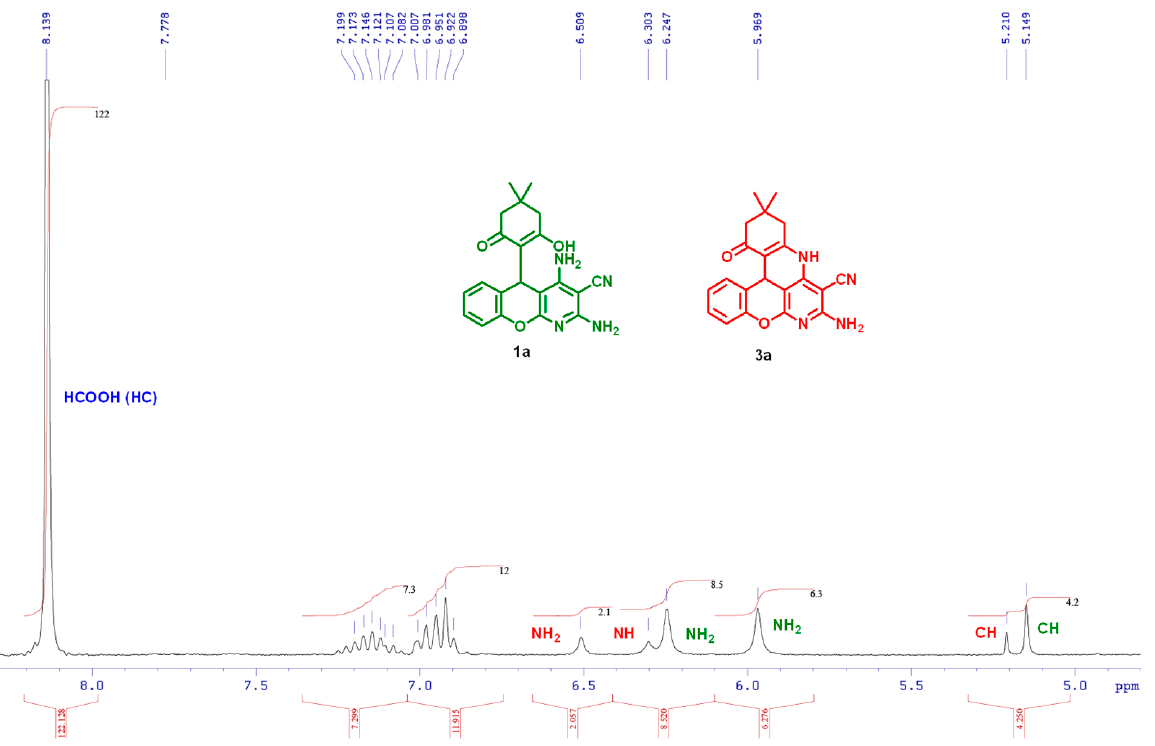
Figure 2. Representative 1 H-NMR spectrum of intramolecular oxidative cyclization in DMSO- d 6 at 353 K recorded 60 min after dissolution.